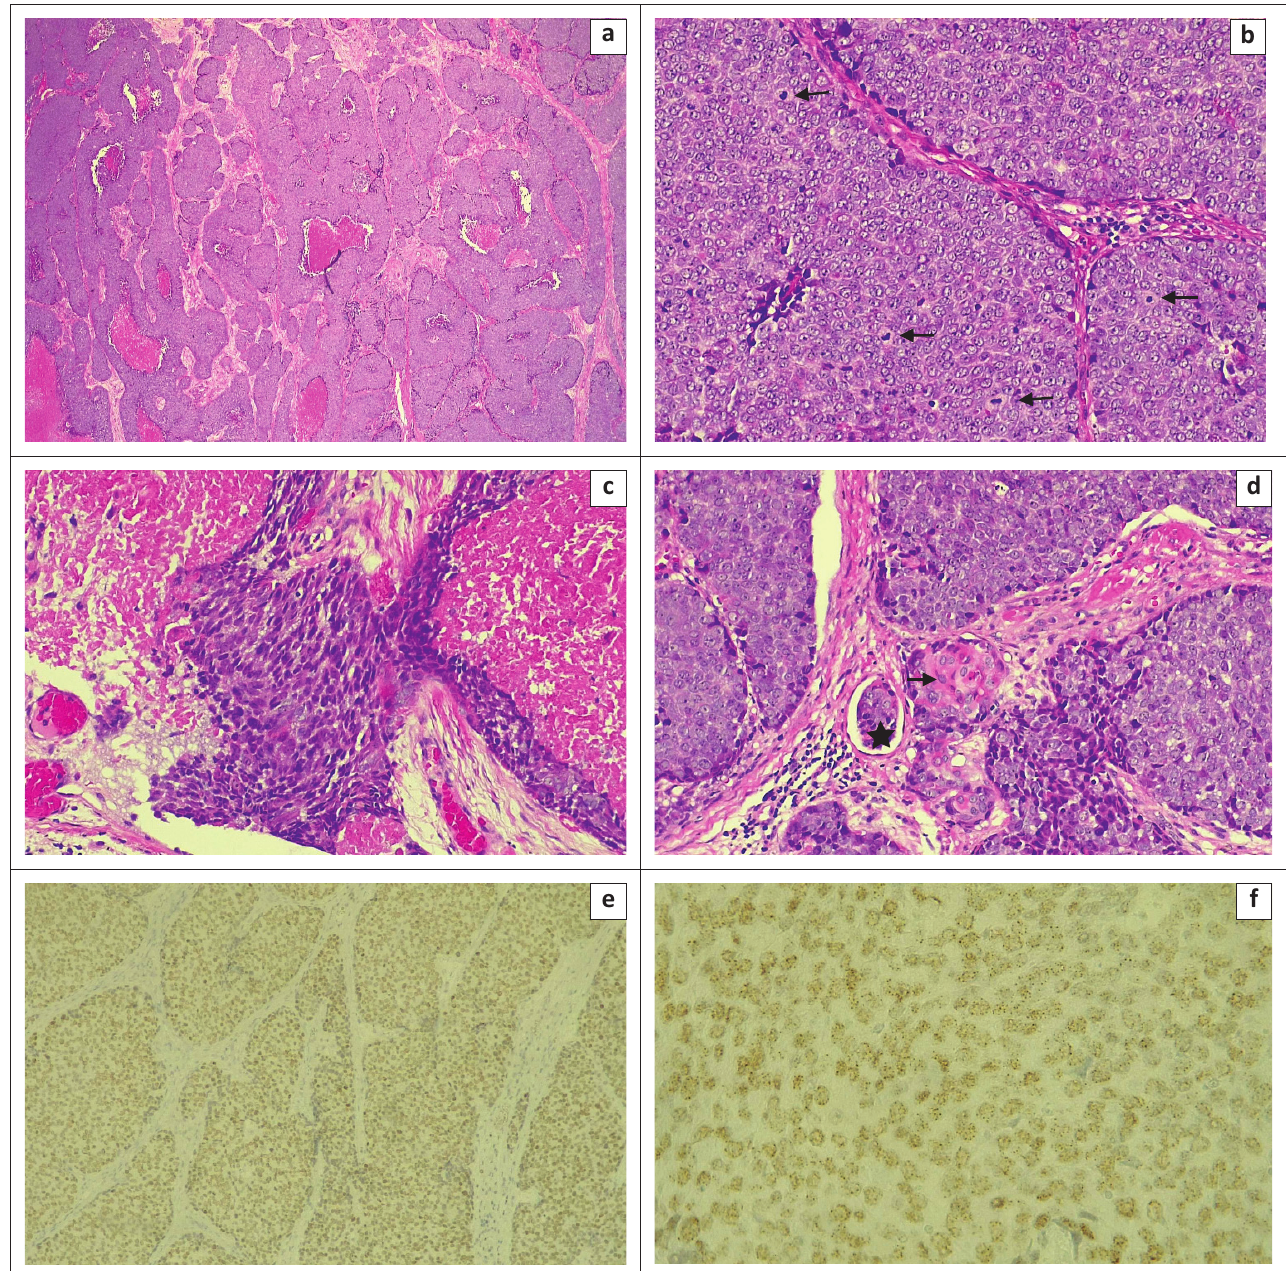
FIGURE 1: Nuclear protein in testis midline carcinoma. (a) Low-power view shows nests, sheets and trabeculae in a desmoplastic stroma with abundant necrosis; 2.5× magnification. (b) Undifferentiated cells with vesicular nuclei and conspicuous nucleoli. Note the abundant mitotic figures (arrows); 10× magnification. (c) Squamous differentiation noted focally; 10× magnification. (d) Cells with more eosinophilic cytoplasm as evidence of abrupt keratinisation (arrow). Note the lymphovascular invasion (star); 20× magnification. (e) Nuclear protein in testis immunohistochemical stain. Note the diffuse pattern of staining; 40× magnification. (f) Speckled nuclear staining pattern considered positive; 40×